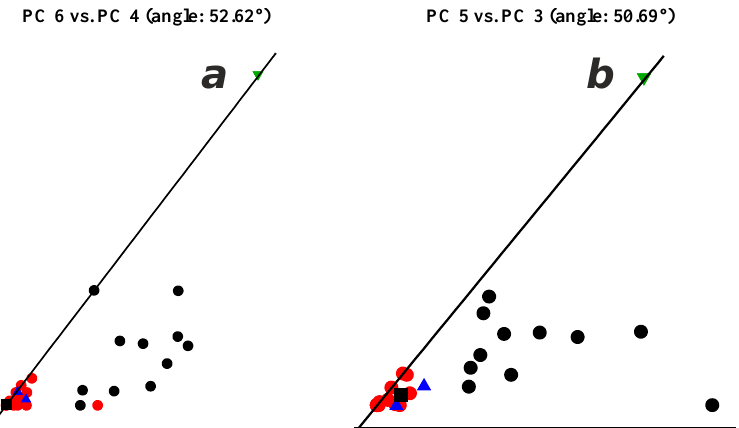
Figure 5. Score graphs of NMF decompositions: ( a ) LIBS only (cf. Figure 4); ( b ) fused Raman + LIBS dataset. Shown are projections with best silhouette metrics.